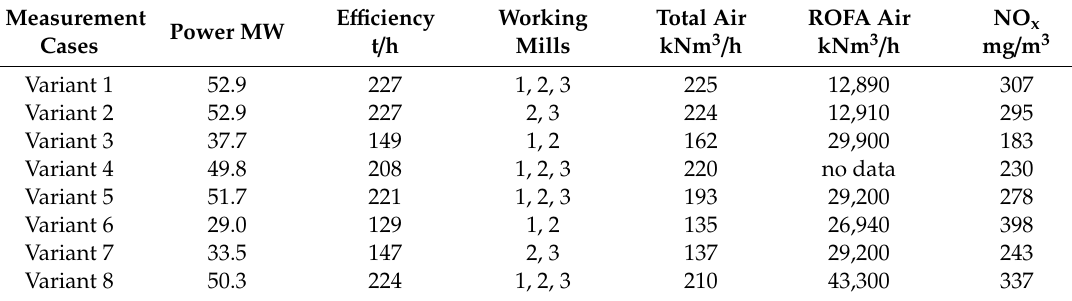
Table 3. Boiler operation during measuring of the flue gases composition in the boundary layer.